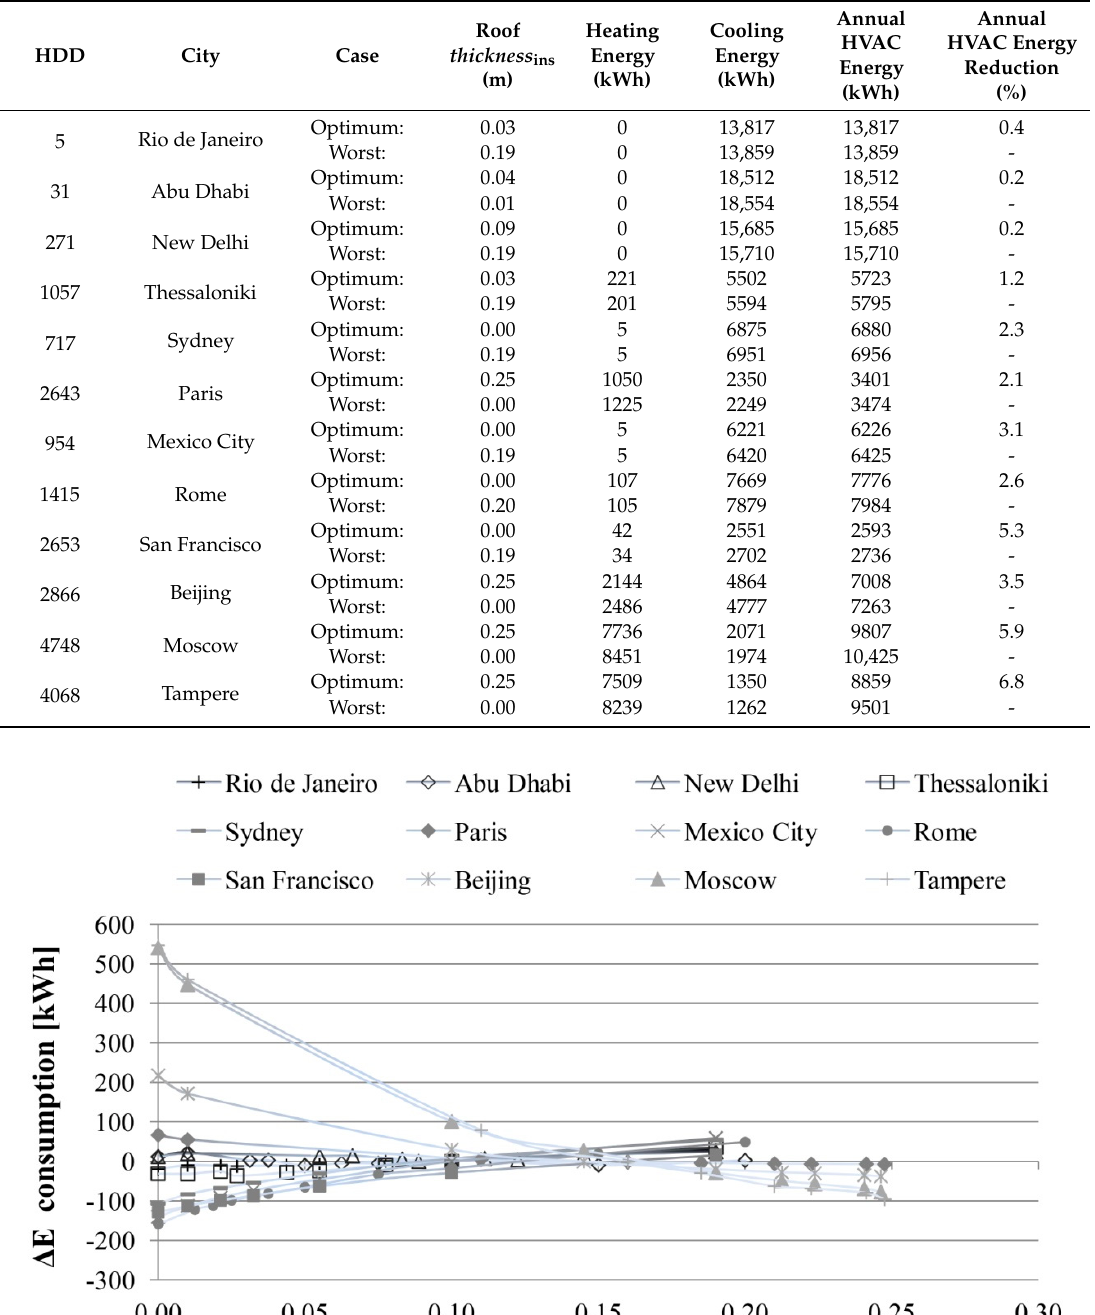
Table 5. Heating, cooling, and annual HVAC energy consumption and energy savings with the optimum roof thermal insulation thickness compared to the worst performing for the case study building with “cool roof” in each climate zone.